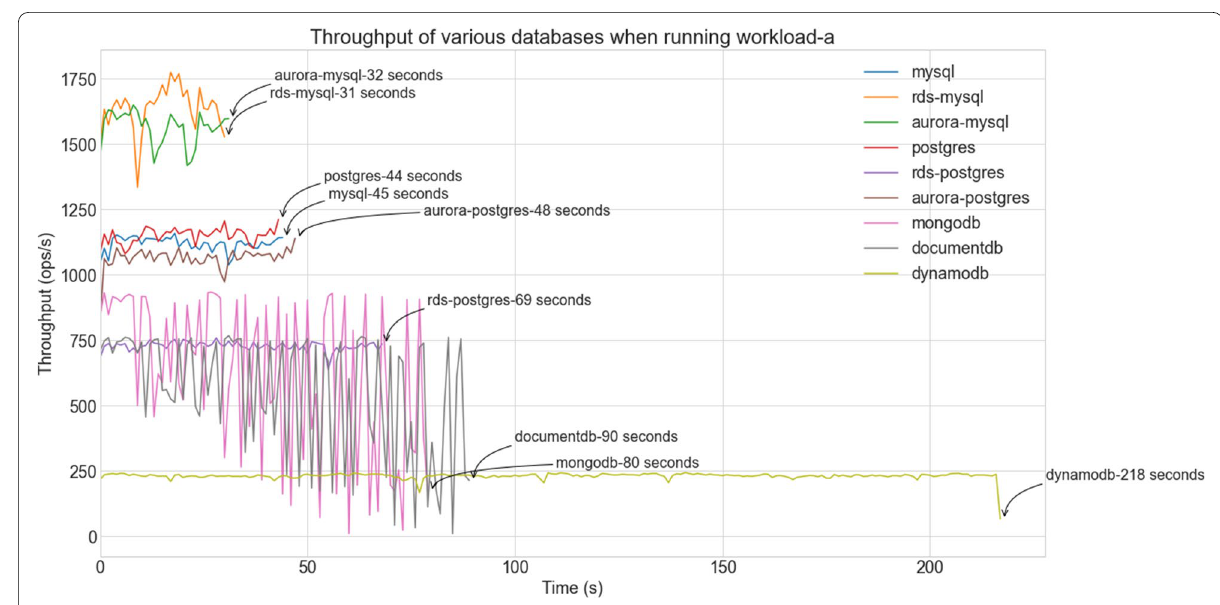
Fig. 5 Performance of databases with Workload‑a (Read‑intensive